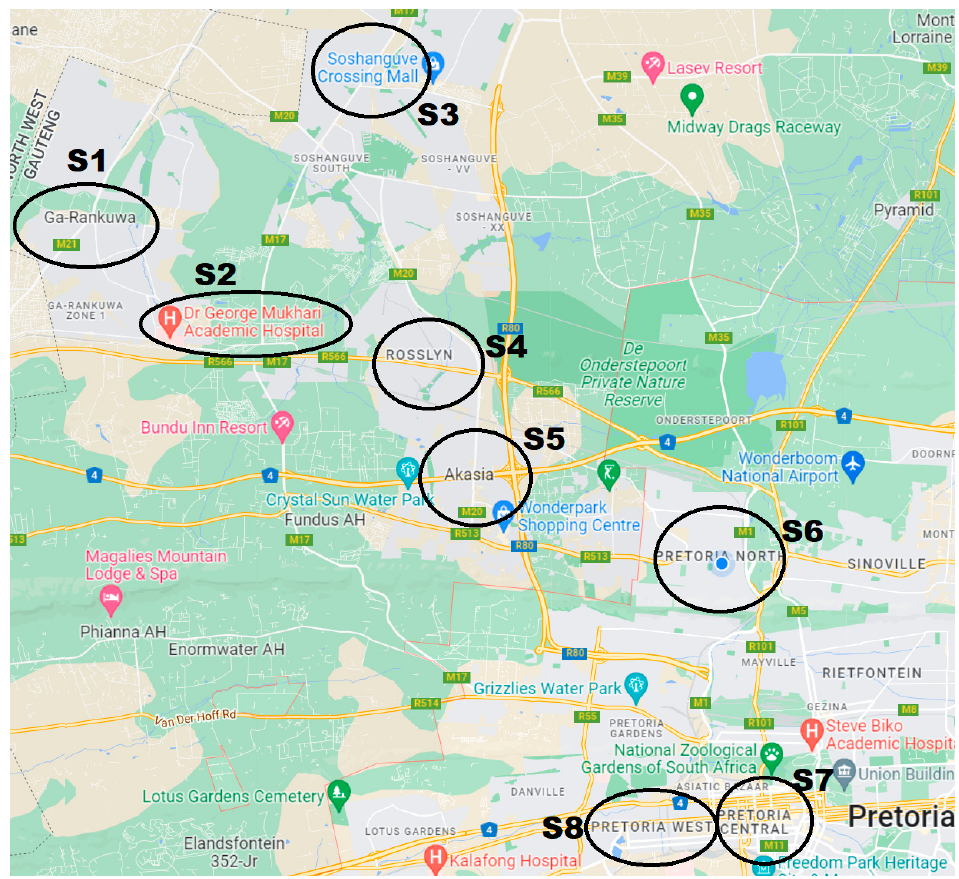
Figure 1. Showing the map of the study area in Pretoria, South Africa.